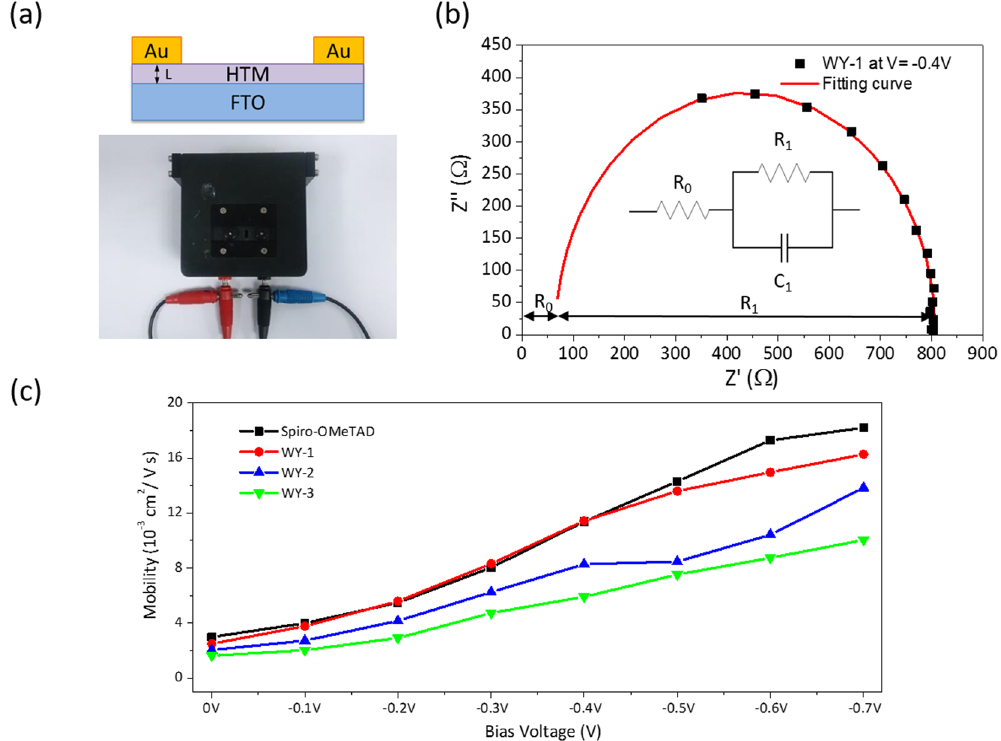
equivalent circuit (inset). ( c ) The calculated hole mobility of HTMs vs. applied bias.